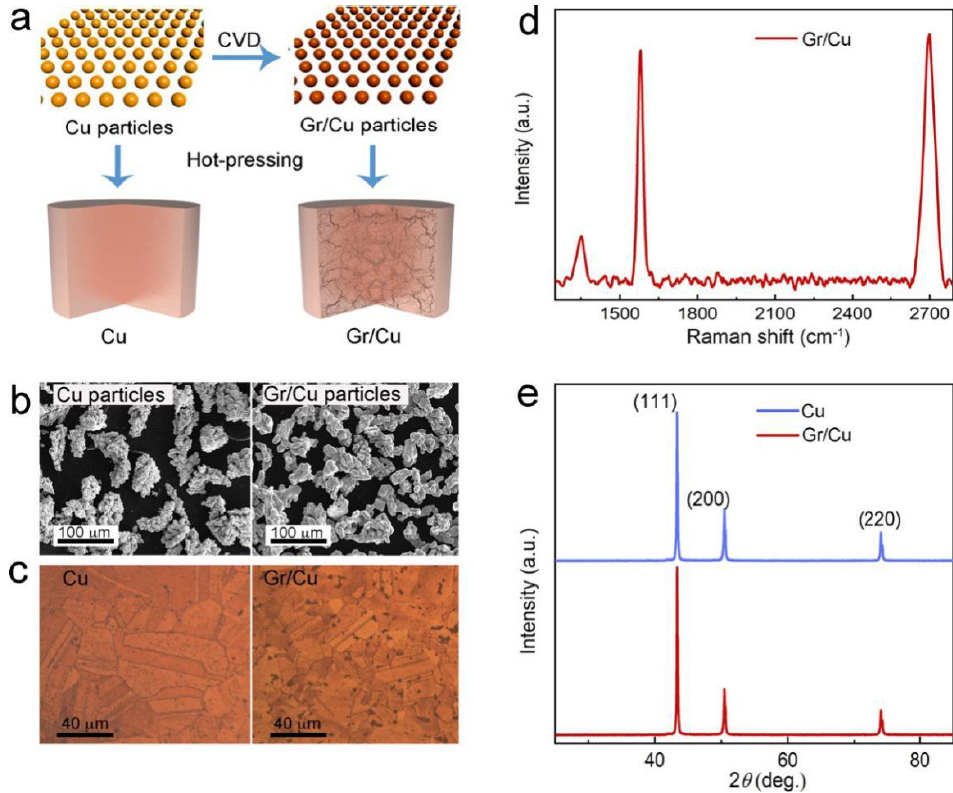
Figure 1. ( a ) Schematic of the fabrication process of Gr/Cu composites with defined graphene microstructure. ( b ) Scanning electron microscopy (SEM) images of Cu powders before and after graphene growth. ( c ) Metallographic images of Cu counterpart and Gr/Cu composites. ( d ) Raman spectrum and ( e ) X-ray diffraction (XRD) pattern of Gr/Cu composites. Legend: CVD, chemical vapor deposition.